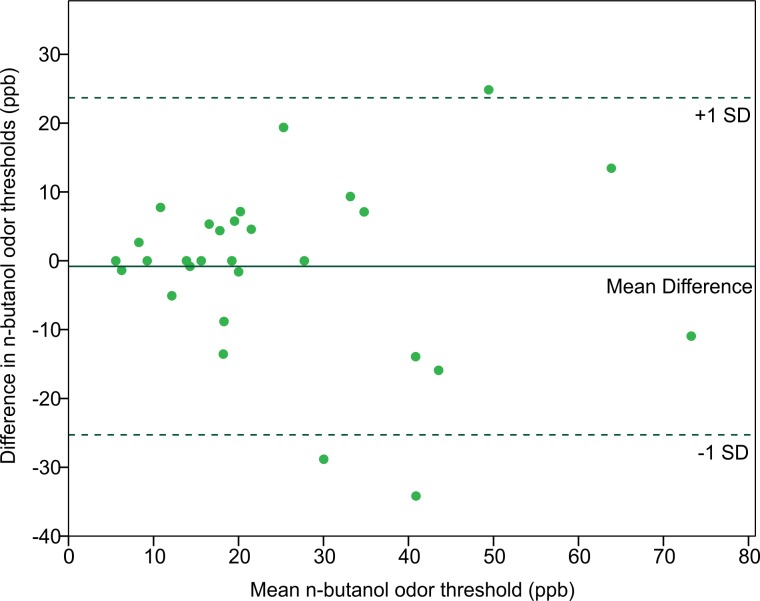
Bland-Altman plot comparing the n-butanol olfactory threshold scores obtained from participants tested twice, 14 to 18 weeks apart.